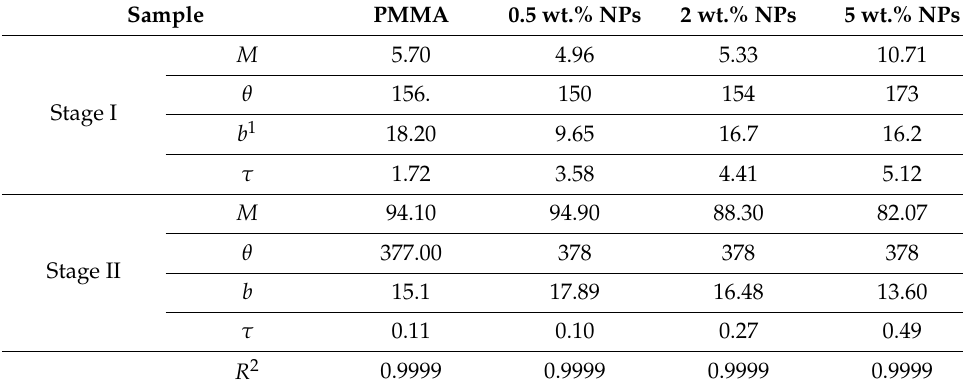
Figure 6. TG curves of PMMA and CuFe 2 O 4 /Cu 2 O/CuO/PMMA composites containing 0.5, 2, and 5 wt.% NPs. Fitted thermal parameters are listed in Table 1. Table 1. Fitted TG thermal